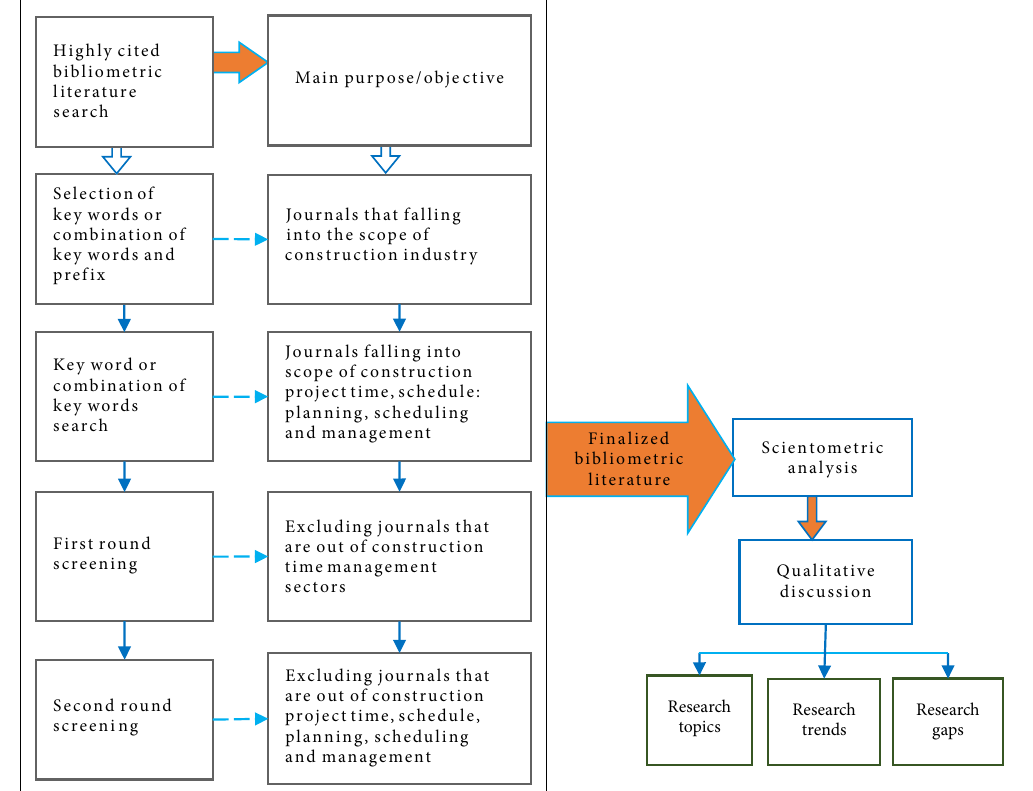
Figure 1. The methodological